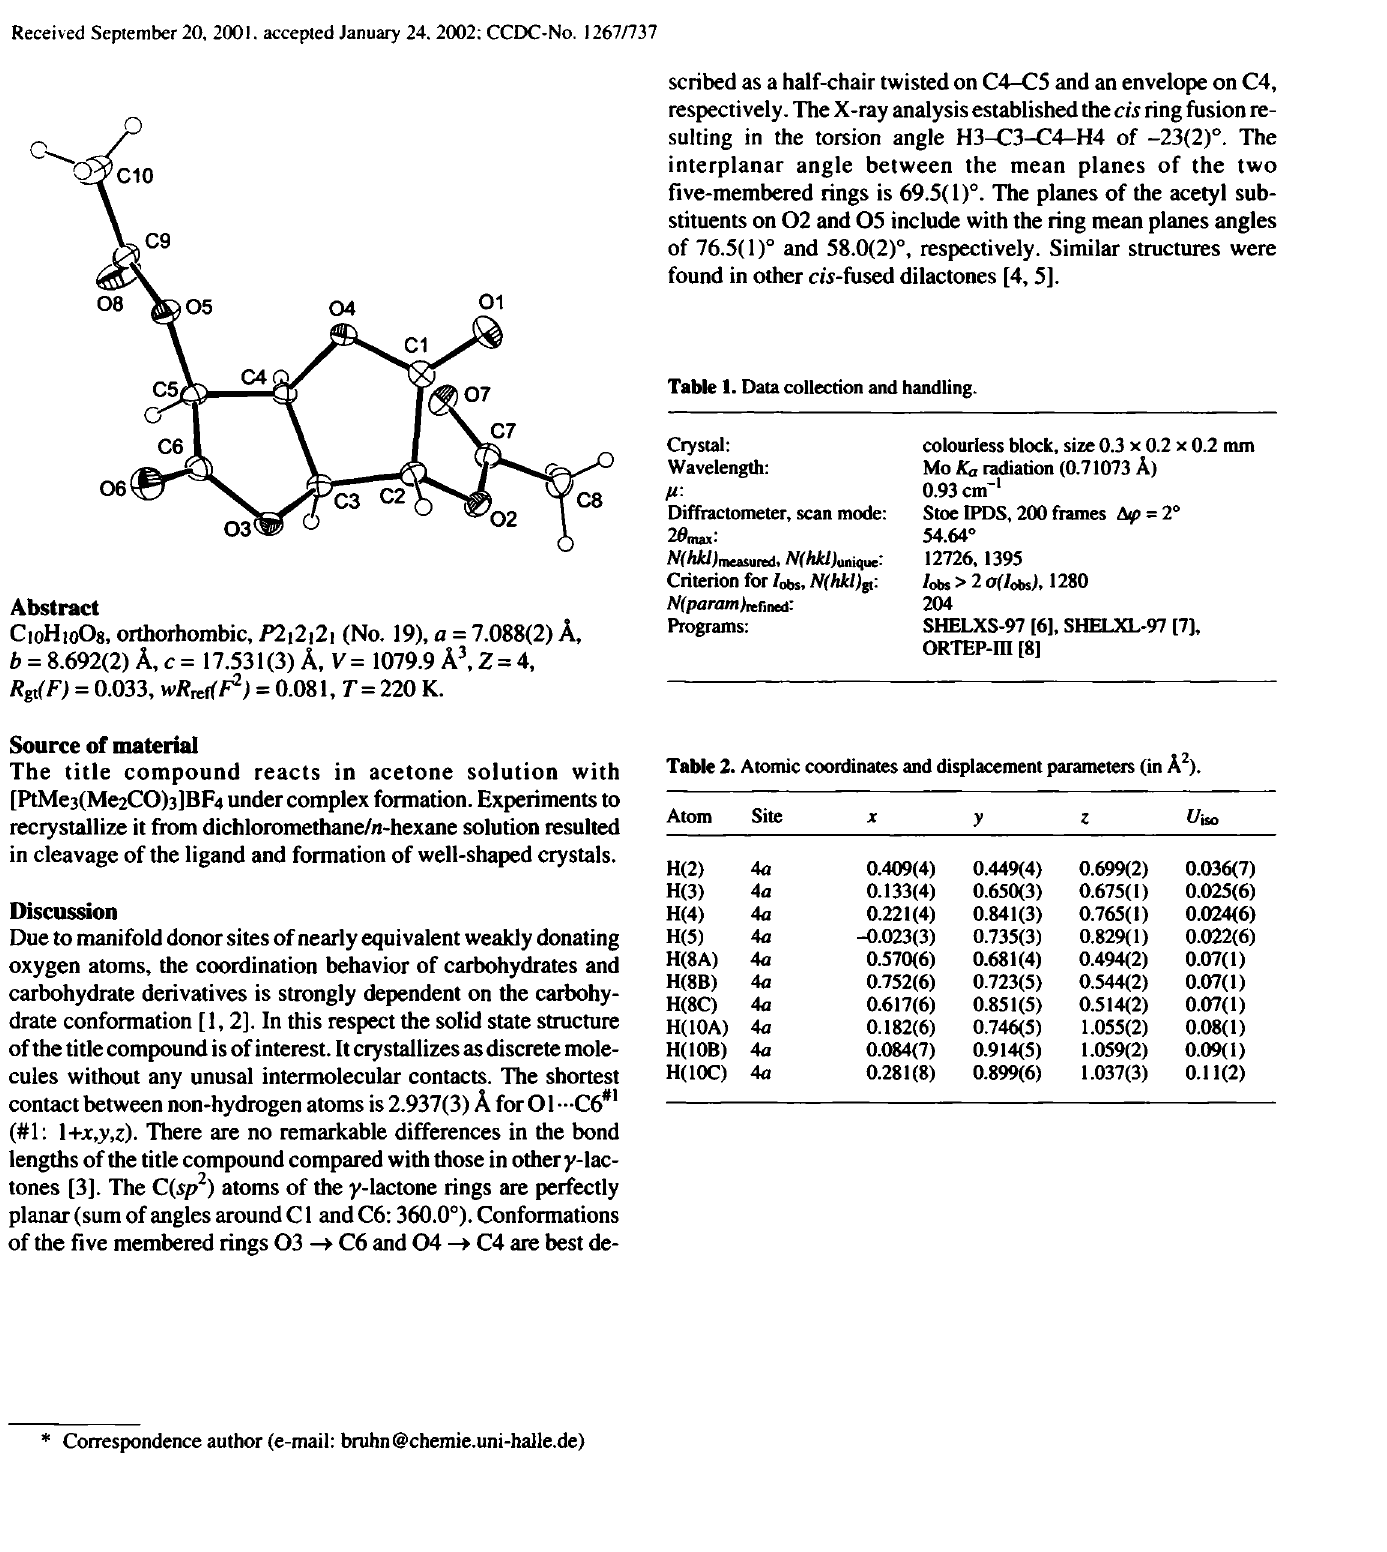
Table 1. Data collection and handling.